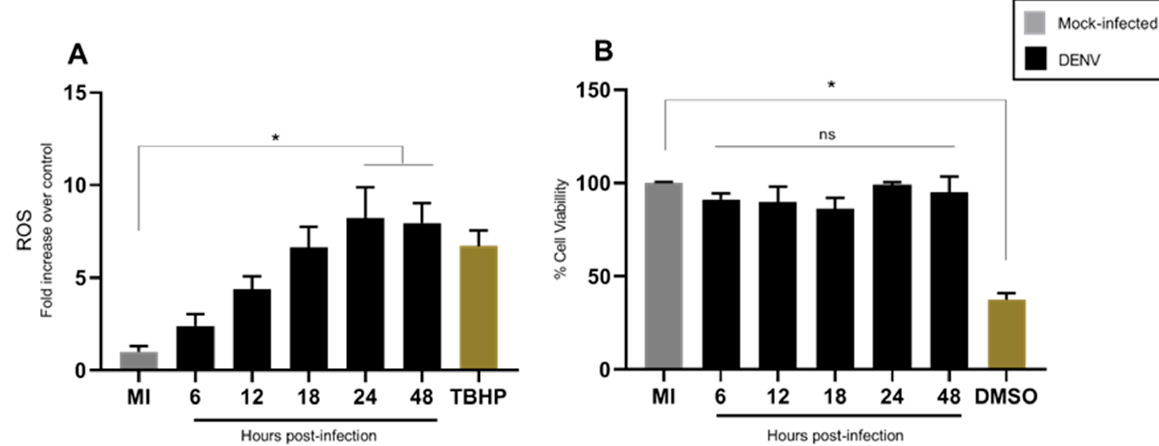
Figure 2. DENV2-infection induced high ROS levels in C6/36 cell line without affecting cell viability. C6/36 cells were infected with DENV2 at MOI 5 and incubated for different periods of time—6, 12, 18, 24, and 48 h post-infection. ( A ) ROS were measured with 5 µ M H2DCFDA. Data are expressed as fold increases over mock infected cells at each time point; TBHP was used as a positive control. ( B ) The cell viability was measured with MTT assay, the results are expressed as percentage of that of mock infected control; as a positive control 10% v / v of DMSO was used 12 h before treatment with MTT. All data are expressed as the mean ± SD obtained from at least three independent experiments. Significance was determined by Kruskal–Wallis test followed by Dunn ´ s multiple comparison test. p < 0.05 (*). ns: non-significant; MI: mock-infected; TBHP: tert-Butyl hydroperoxide; DMSO: dimethylsulfoxide; DENV: dengue virus.